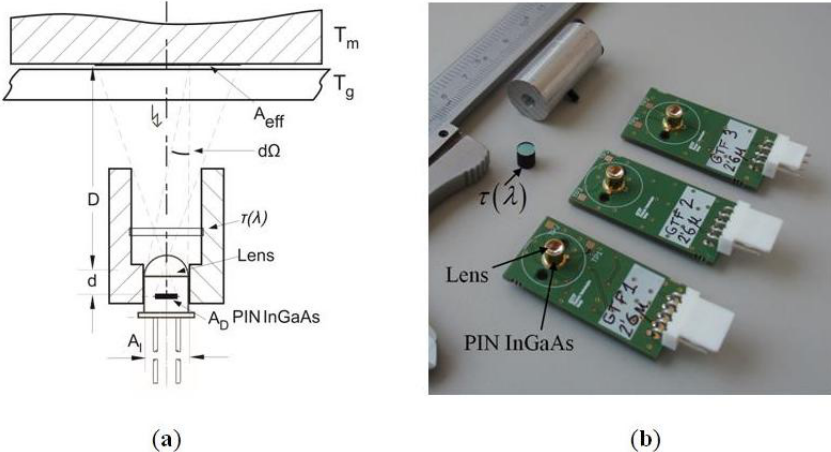
Figure 4. ( a ) Optical system, including dimensions, geometry, effective area of the radiation and the solid angle subtended by the lens. D = 30 – 33 mm, d = 3.6 mm, A and A = 0.78 mm 2 (1 mm diameter); ( b ) Implemented optical system, including PIN D InGaAs, filter     and